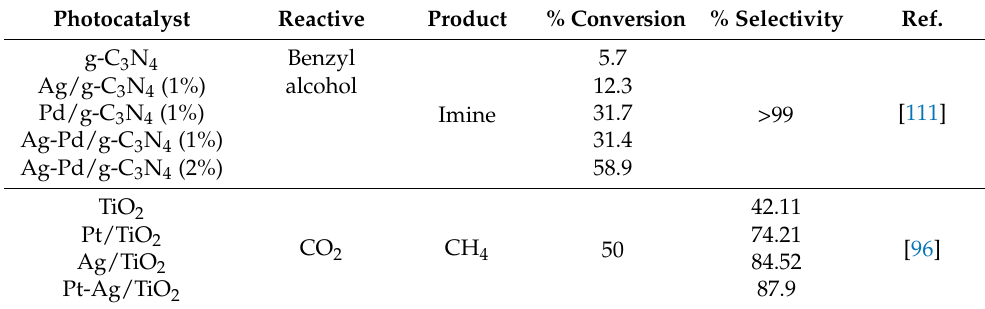
Table 2. Examples of selective conversion using catalysts with bimetallic doping at λ (Xe > 400